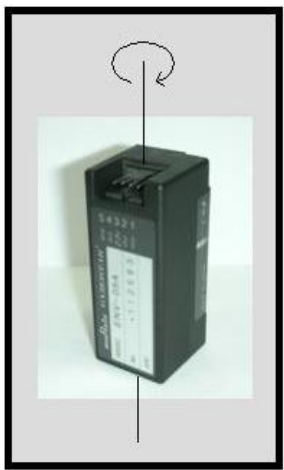
Figure 2. Murata Gyrostar